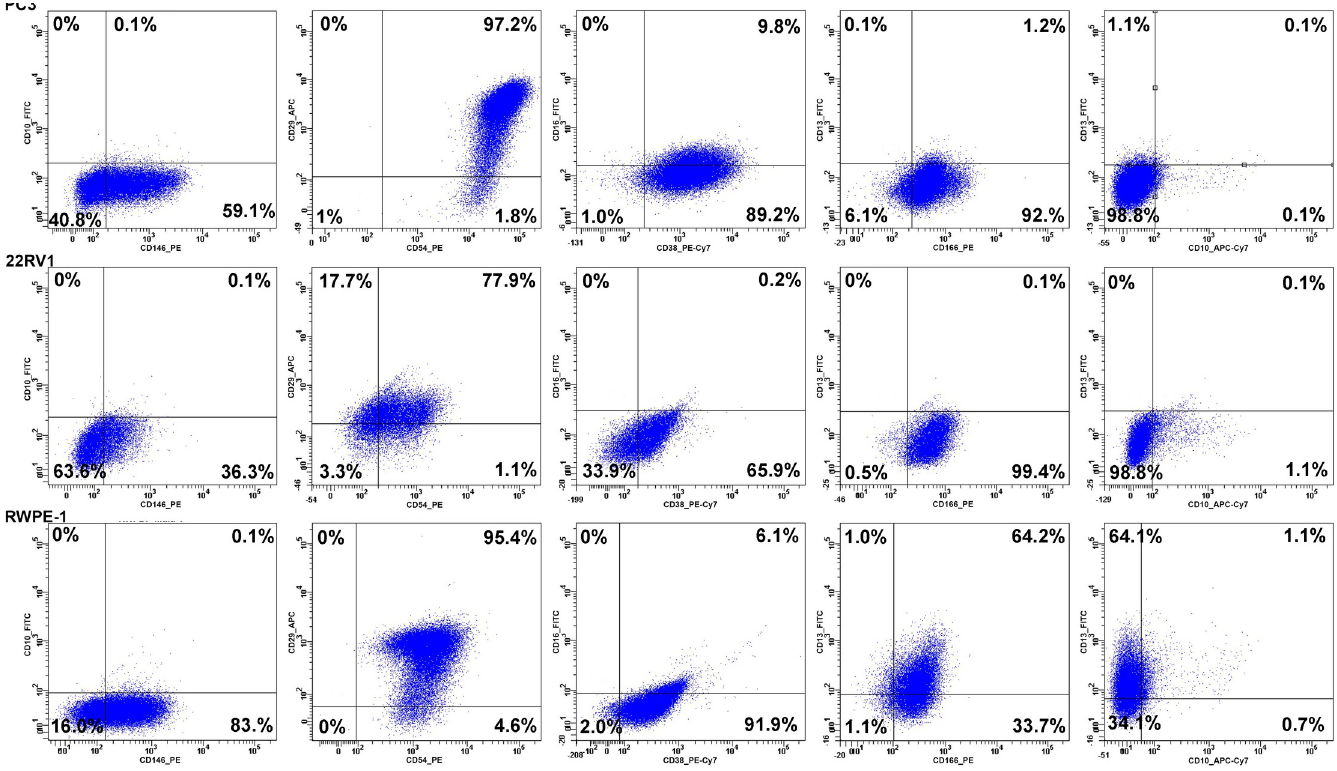
Fig 3. Extended surface phenotypes of model prostate cell lines.